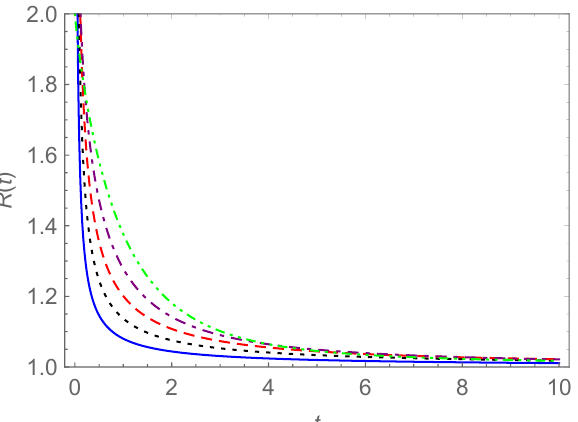
Figure 12. Curves of the relaxation modulus R ( t ) in Equation (78) for b 0 = b 1 = b 2 = 1, β = 0.9, and α = 0.1 (solid line), 0.3 (dotted line), 0.5 (dashed line), 0.7 (dotted–dashed line), and 0.9 (dotted– dotted–dashed line).